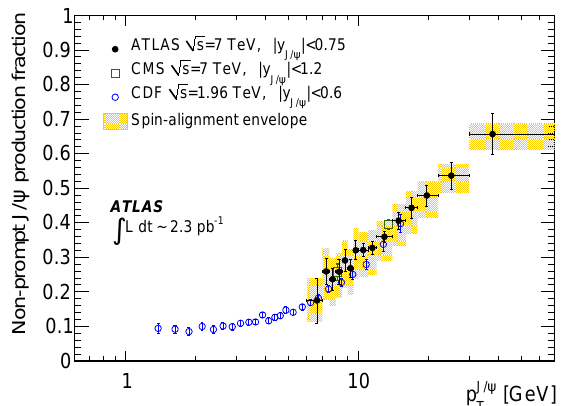
Fig. 2. Production fraction of non-prompt to inclusive J /ψ as a function of J /ψ transverse momentum. Overlaid is a band rep- resenting the maximal variation of the result under various spin- alignment scenarios. Comparison is made to existing CDF and CMS results.